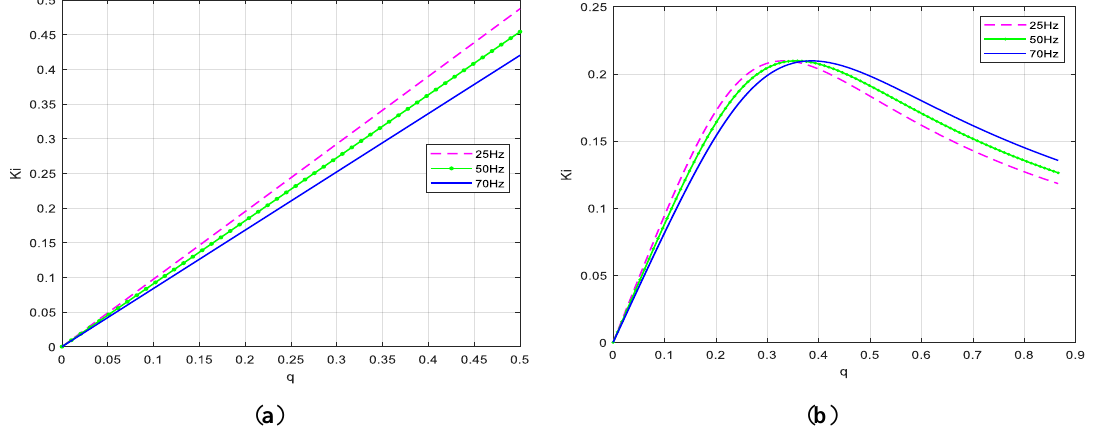
Figure 9. Static characteristics of current gain: ( a ) Venturini modulation, ( b ) SVM.